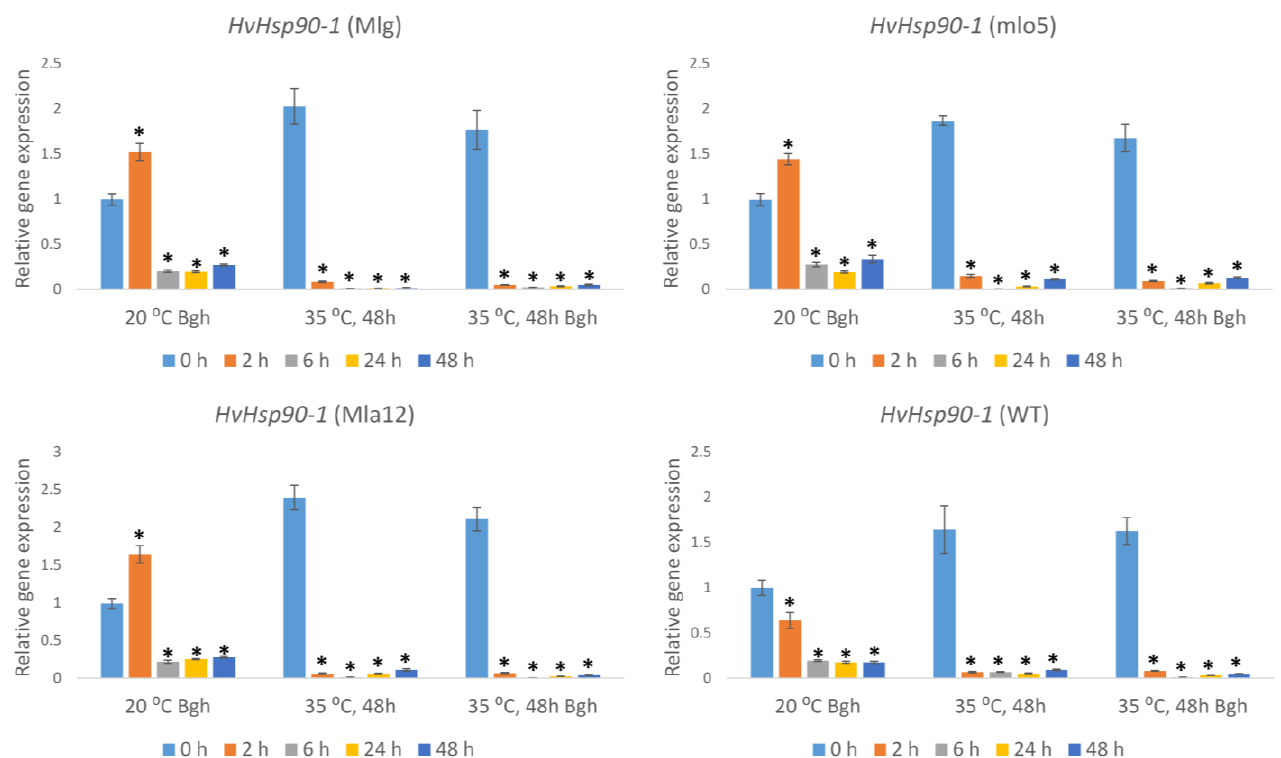
Figure 5. Expression of the barley Heat shock protein 90-1 ( HvHsp90-1 ) gene as detected by RT-qPCR in resistant (Mlg, mlo5, Mla12) and susceptible (WT) Hordeum vulgare cv. Ingrid near-isogenic lines at early time points (0 h, 2 h, 6 h, 24 h, and 48 h) following powdery mildew ( Blumeria graminis f. sp. hordei A6, Bgh) inoculation and/or heat stress. Heat stress treatments at 35 °C for 48 h were applied immediately before Bgh inoculation. Inoculated but not heat-treated (20 °C Bgh) and heat-treated but not inoculated (35 °C for 48 h) plants were used as controls. The graphs show the average of three experiments. Error bars represent standard deviation. Asterisks ( * ) indicate statistically significant differences from 0 h for each specific treatment at p < 0.05.